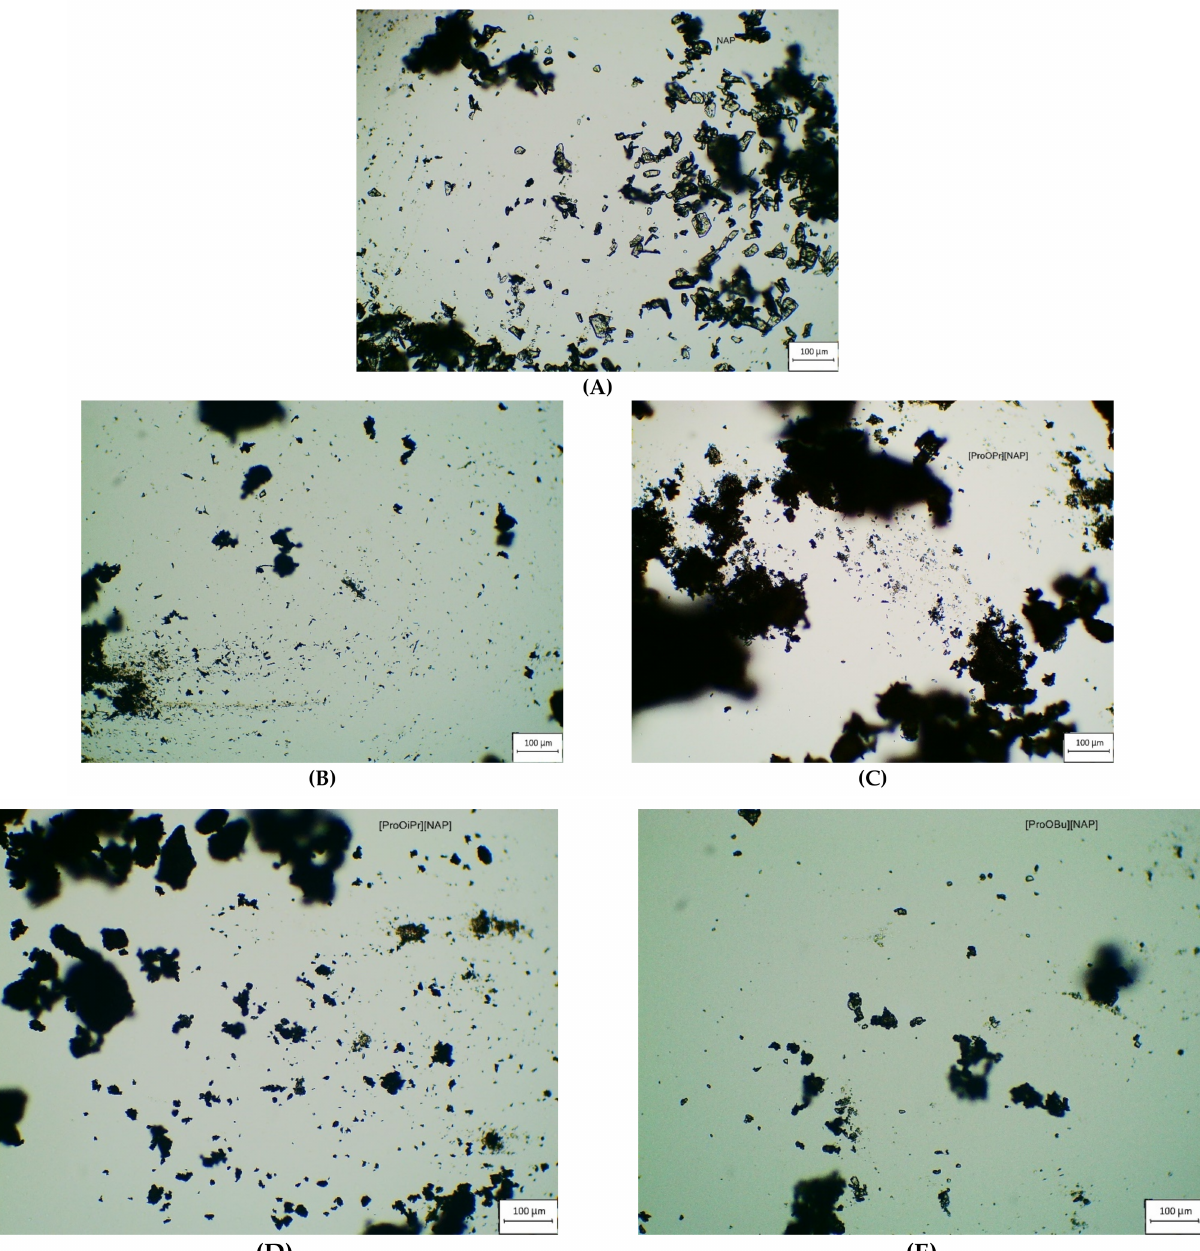
Figure 8. Micrographs of ( A ) [NAP], ( B ) [ProOEt][NAP], ( C ) [ProOPr][NAP], ( D ) [ProOiPr][NAP], and ( E )